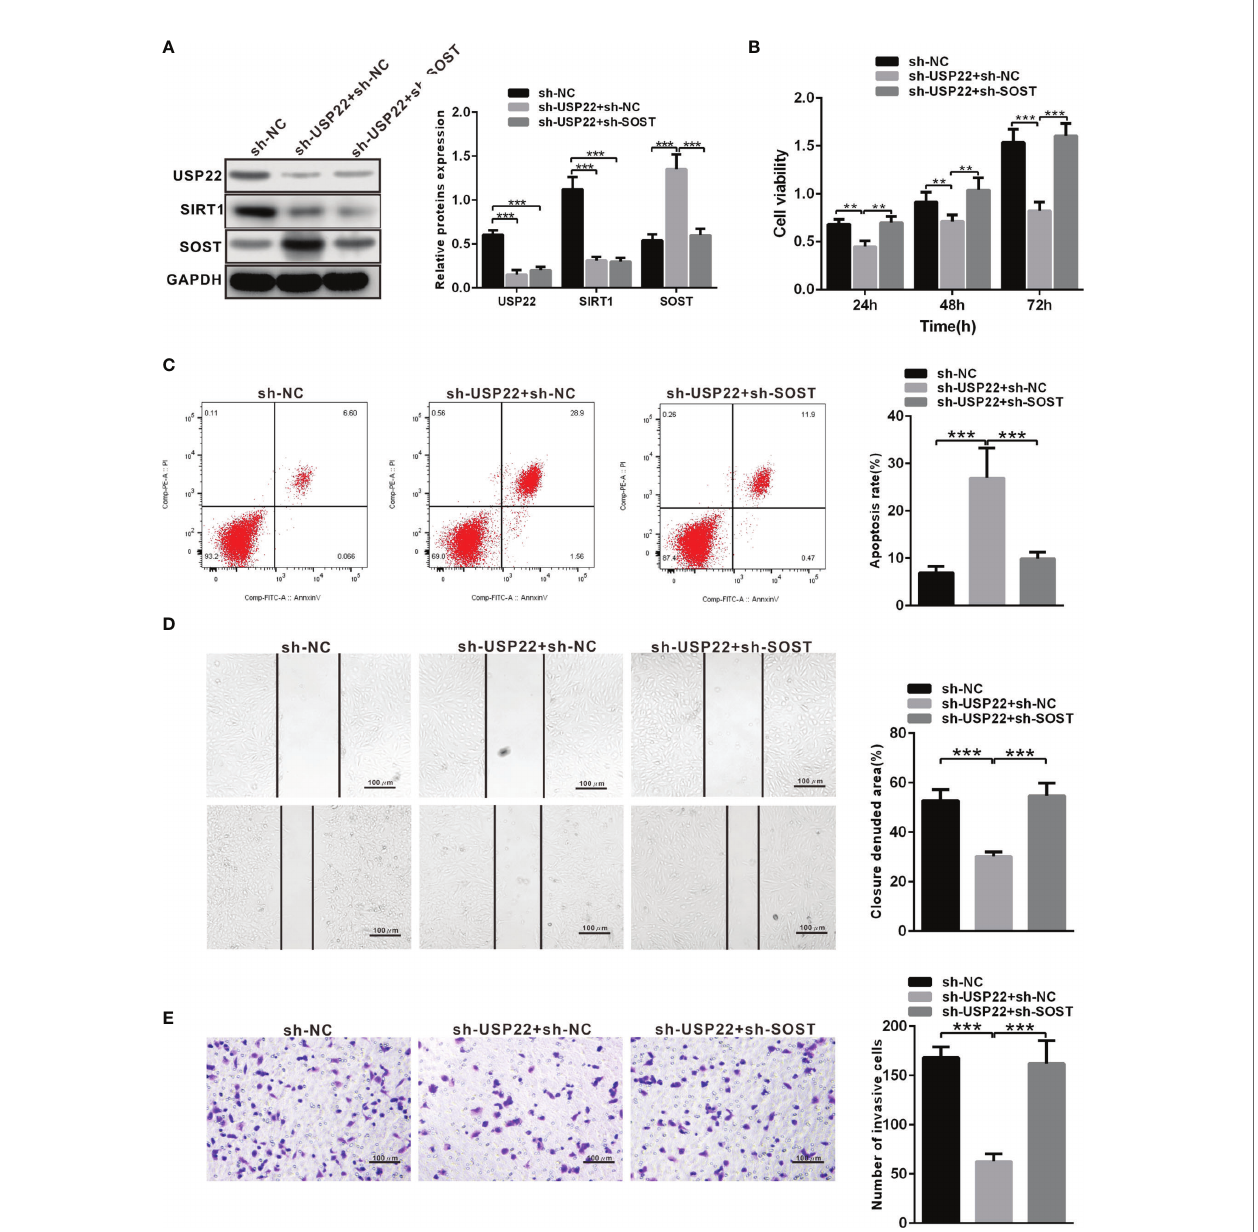
FIGURE 5 | USP22 promotes the occurrence of RB through SIRT1/SOST axis. (A) USP22, SIRT1 and SOST expression in sh-USP22-transfected Y79 cells was detected using western blot analysis. (B) Cell viability was measured by CCK-8. (C) Cell apoptosis was measured using fl ow cytometry. (D) Cell migration was detected using scratch test. (E) Cell invasion was assessed by Transwell assay. ** p < 0.01, *** p < 0.001. The measurement data was expressed by mean ± standard deviation. The two groups of data conforming to the normal distribution were compared using unpaired t